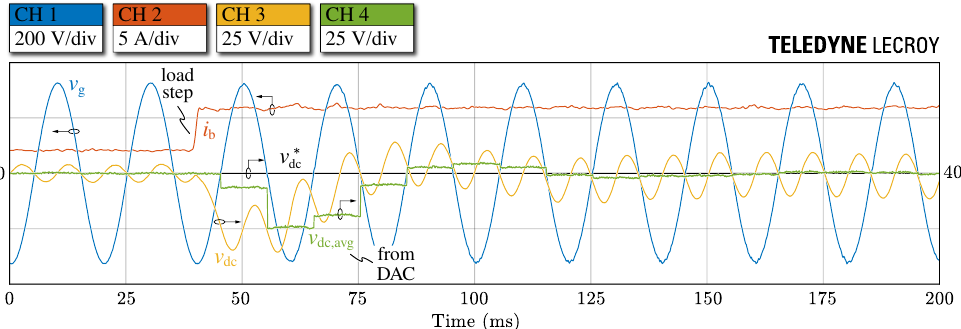
Figure 17. Experimental DC-link voltage ( v dc ) response to a load step between P = 800W ( ≈ 25%) and P = 2400W ( ≈